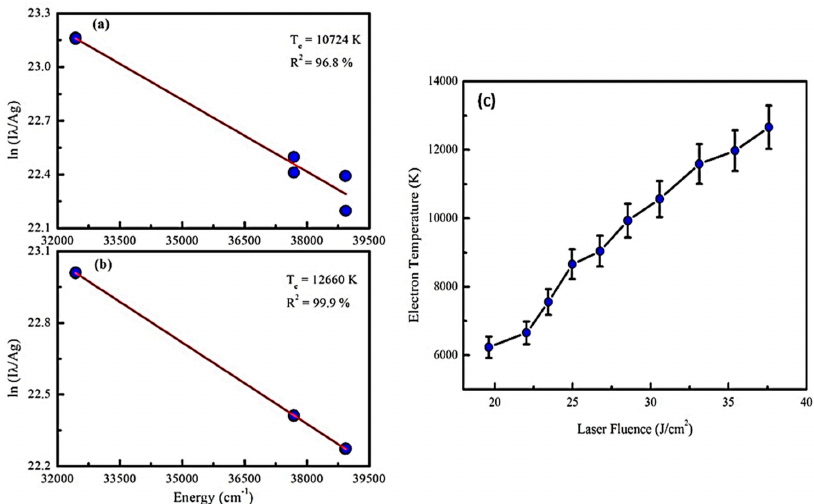
Figure 5. Boltzmann plots drawn using Al-I lines at laser fluence 37.6 J · cm − 2 : ( a ) without and ( b ) with correction for self-absorption in the intensity of the spectral lines ( c ) variation of electron temperature with the laser fluence ranging (19.6–37.6) J · cm − 2